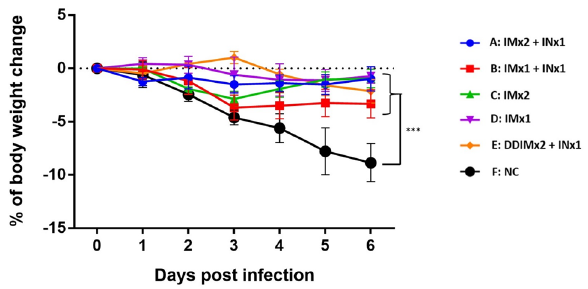
Figure 4. Changes in body weight post-SARS-CoV-2 infection. Results are presented as the mean ± S.E.M. Differences between negative control group and other experimental groups of animals were analyzed by two-